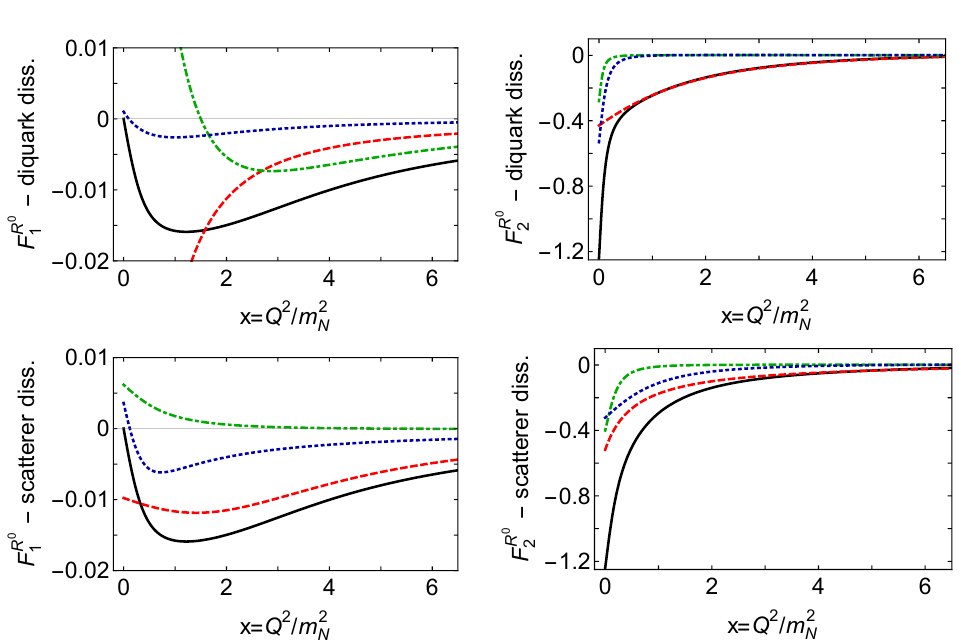
Figure 6. Dirac (left) and Pauli (right) elastic form factors of neutral-Roper. Upper panels – diquark breakdown: DD1 (dashed red), scalar diquark in initial and final baryon; DD2 (dot-dashed green), pseudovector diquark in both initial and final states; DD3 (dotted blue), scalar diquark in incoming baryon, pseudovector diquark in outgoing baryon, and vice versa. Lower panels – scatterer breakdown: DS1 (red dashed), photon strikes an uncorrelated dressed quark; DS2 (dot-dashed green), photon strikes a diquark; and DS3 (dotted blue), diquark breakup contributions, including photon striking exchanged